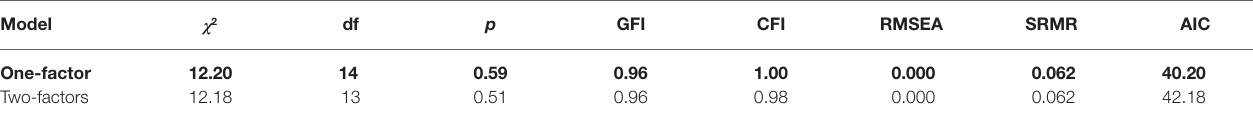
TABLE 4 | Goodness of fit indices for the alternative measurement models (confirmatory factor analyses) of working memory capacity, inhibition, and shifting measures. Model